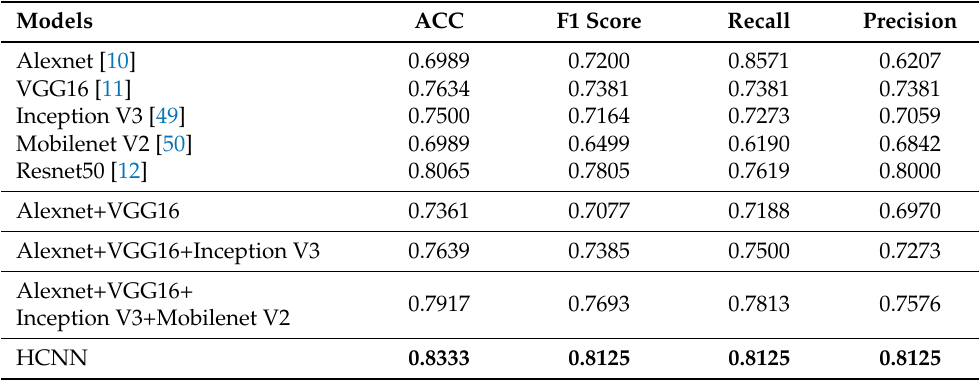
Table 2. The ablation analysis on the ultrasonic image